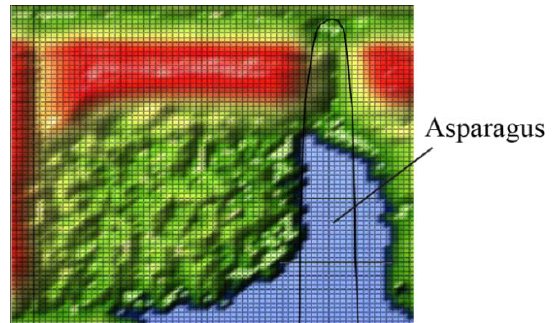
Figure 12. The transmission image of the wedge sample holder filled with Soil 1 and asparagus. The image is in arbitrary units in rainbow colors from red, high intensity, to blue, low intensity. The image size is 60 mm by 60